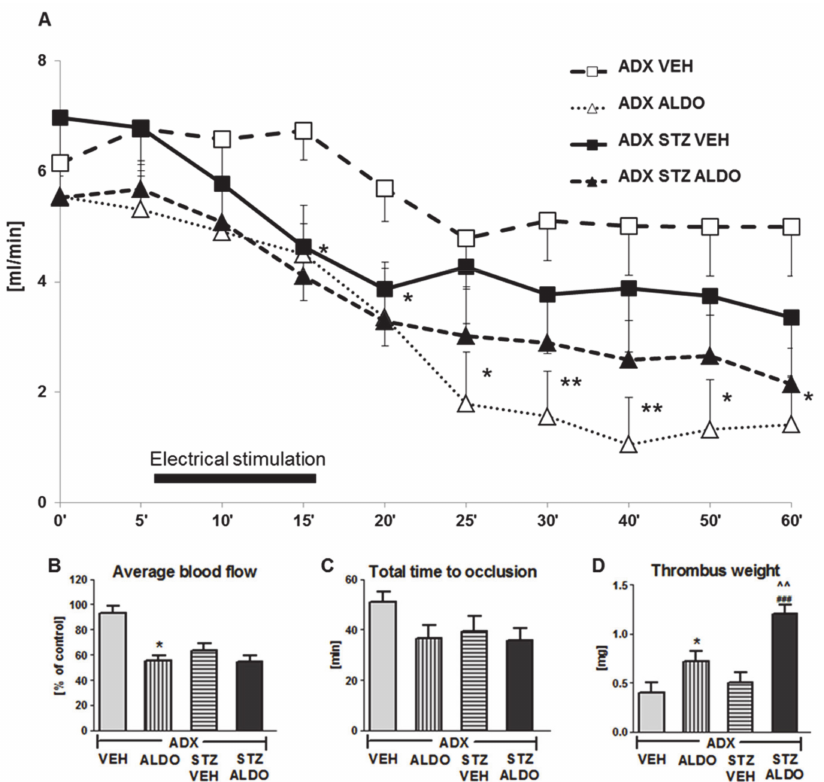
Figure 2. Time-course of mean blood flow and thrombus formation in common carotid artery during aldosterone infusion in adrenalectomized and adrenalectomized streptozotocin-induced diabetic rats. ( A ) The mean carotid blood flow during the entire experiment; ( B ) average blood flow; ( C ) total time to occlusion; ( D ) thrombus weight; ADX VEH—adrenalectomized rats, infused with vehicle; ADX ALDO—adrenalectomized rats, infused with aldosterone; ADX STZ VEH—adrenalectomized streptozotocin-induced diabetic rats, infused with vehicle; ADX STZ ALDO—adrenalectomized streptozotocin-induced diabetic rats, infused with aldosterone. Data are presented as mean ± SEM; * p < 0.05, ** p < 0.01 vs. ADX VEH; ### p < 0.001 vs. ADX STZ VEH; ˆˆ p < 0.01 vs. ADX ALDO; n =